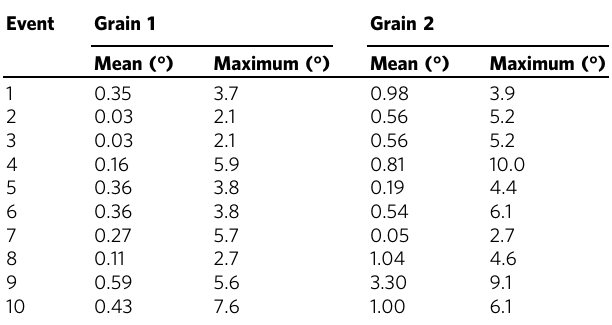
Table 4 Mean and maximum deviations of voxel orientations from the average orientations of the grains that meet at the crack resistant GBs in each